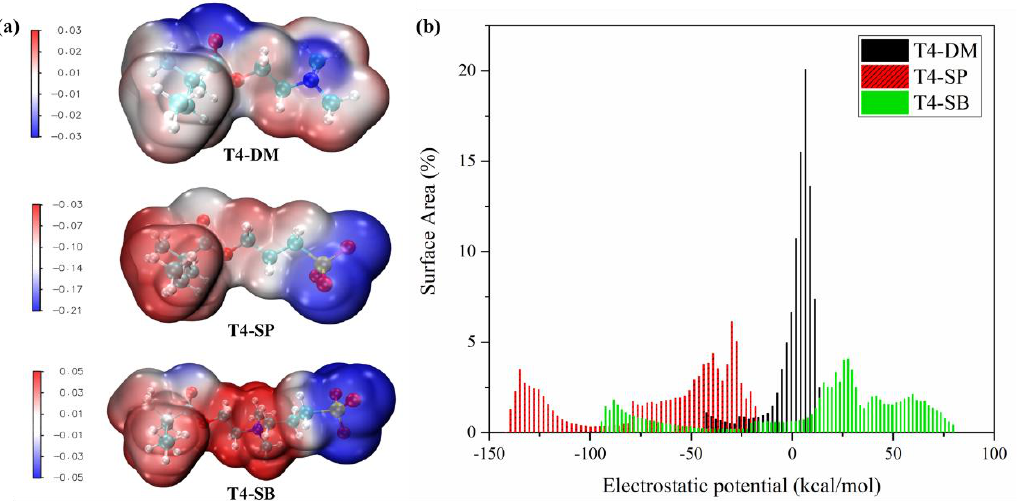
Figure 9. Electrostatic potential of monomers of three antifouling polymers’ monomers. ( a ) Elec- trostatic potential mapped on vdW surface; ( b ) distribution of surface area percentage of different electrostatic potentials.